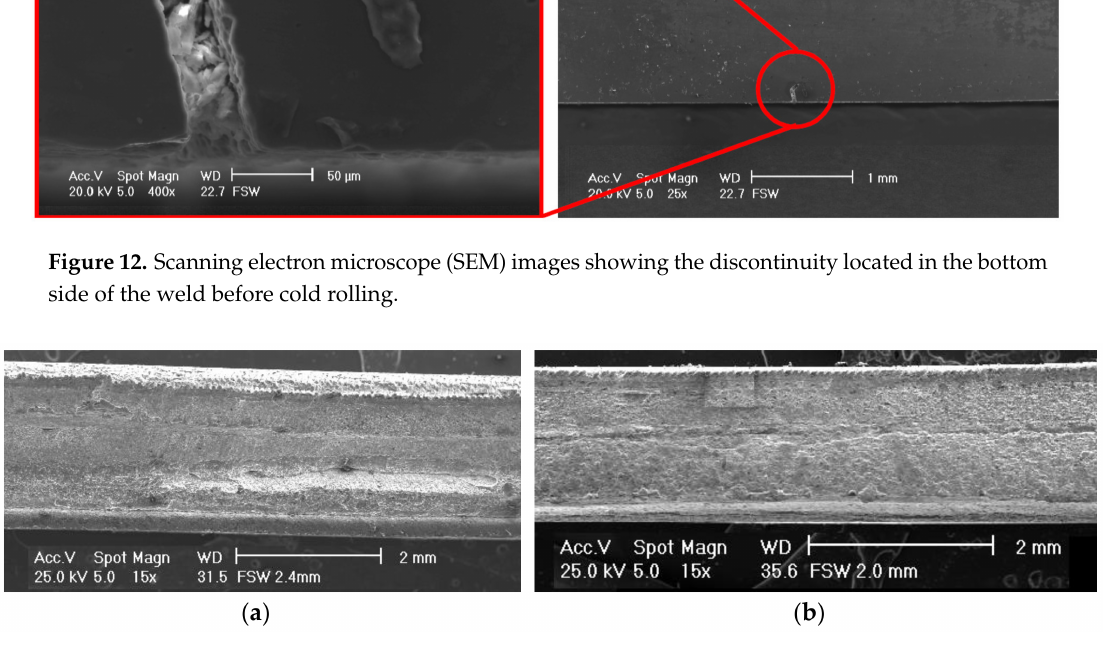
Figure 13. Scanning electron microscope fractography of the FSWed+CRed samples deformed in the cold rolling direction: ( a ) ∆ h = 0.1 mm; ( b ) ∆ h = 0.5